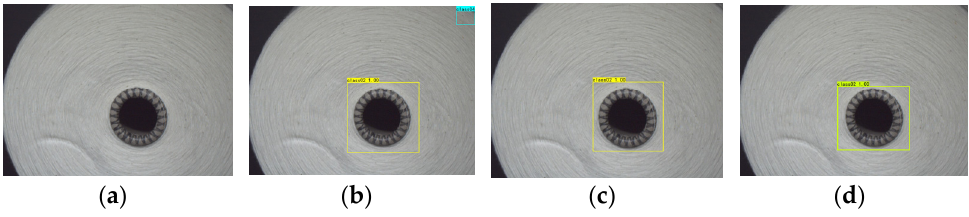
Figure 12. Identification of normal cone yarn with black twill bobbin: ( a ) original image; ( b ) YOLOv3 + DarkNet-53 algorithm recognition results; ( c ) Faster R-CNN + VGG16 algorithm recognition results; ( d ) Faster R-CNN + ResNet50 algorithm recognition results.